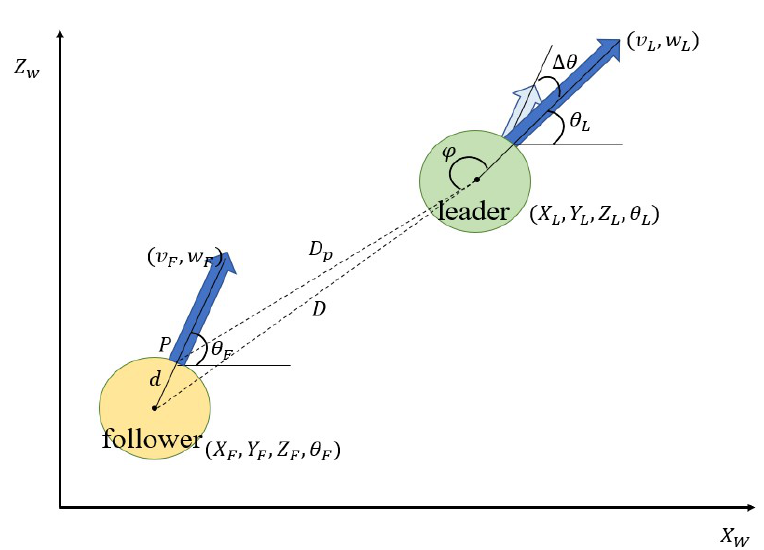
Figure 7. The schematic diagram of the formation movements taken by a pair of leader-follower robot